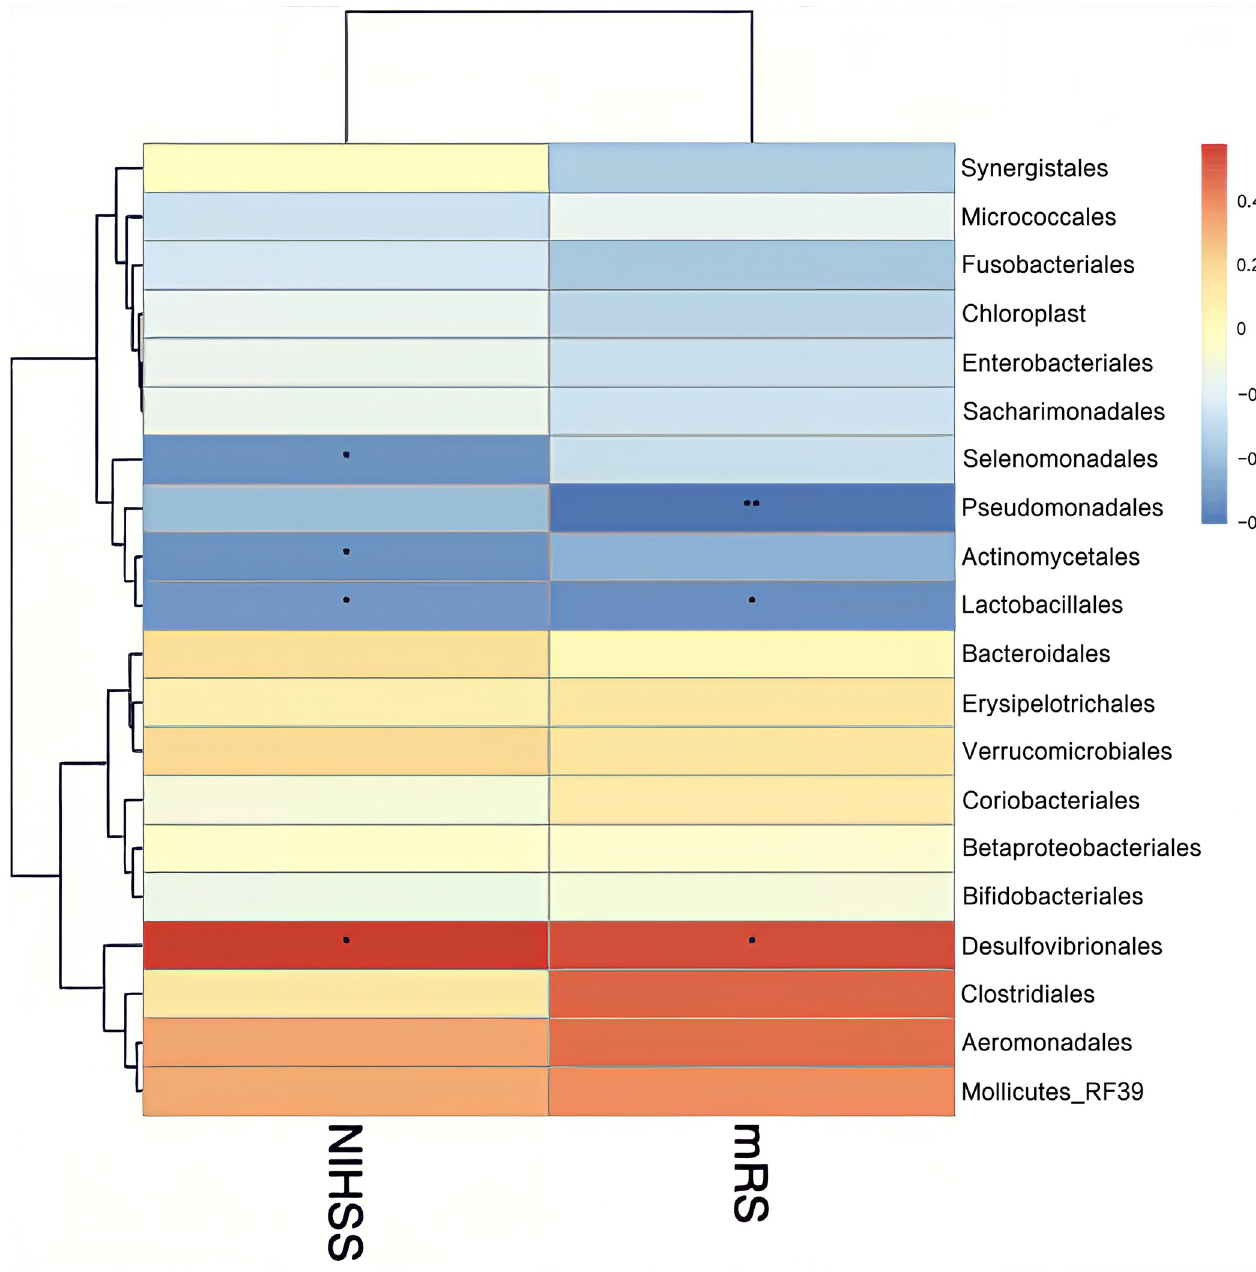
Fig 10. Heatmap of the Spearman correlation coefficients between the gut microbiota at the order level and severity of stroke measured by NIHSS and mRS scores at admission. � P < 0.05, �� P < 0.01. NIHSS: National Institutes of Health Stroke Scale, mRS: modified Rankin Scale.